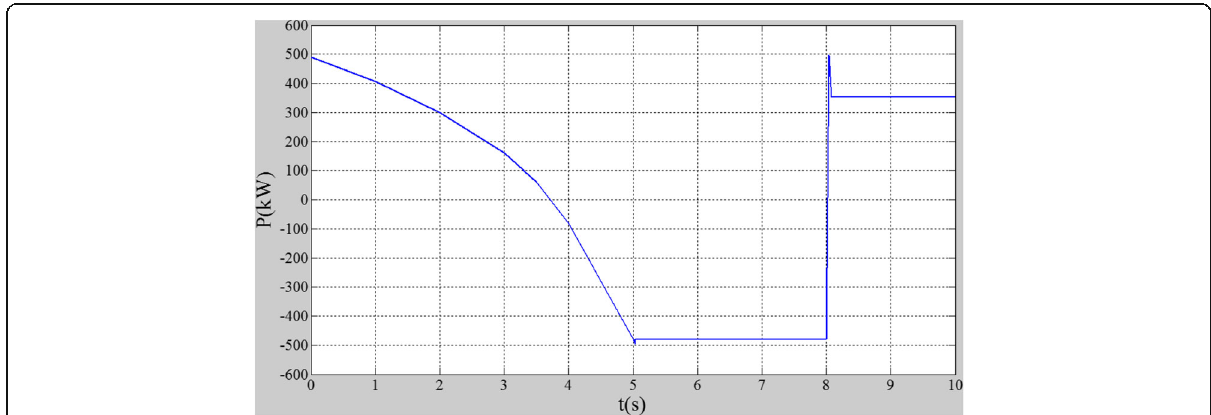
Fig. 9 Power of the double rotor speed-regulating generator. In Fig. 9, X -axis is time (s) and Y -axis is electrical power of the double rotor speed regulating generator